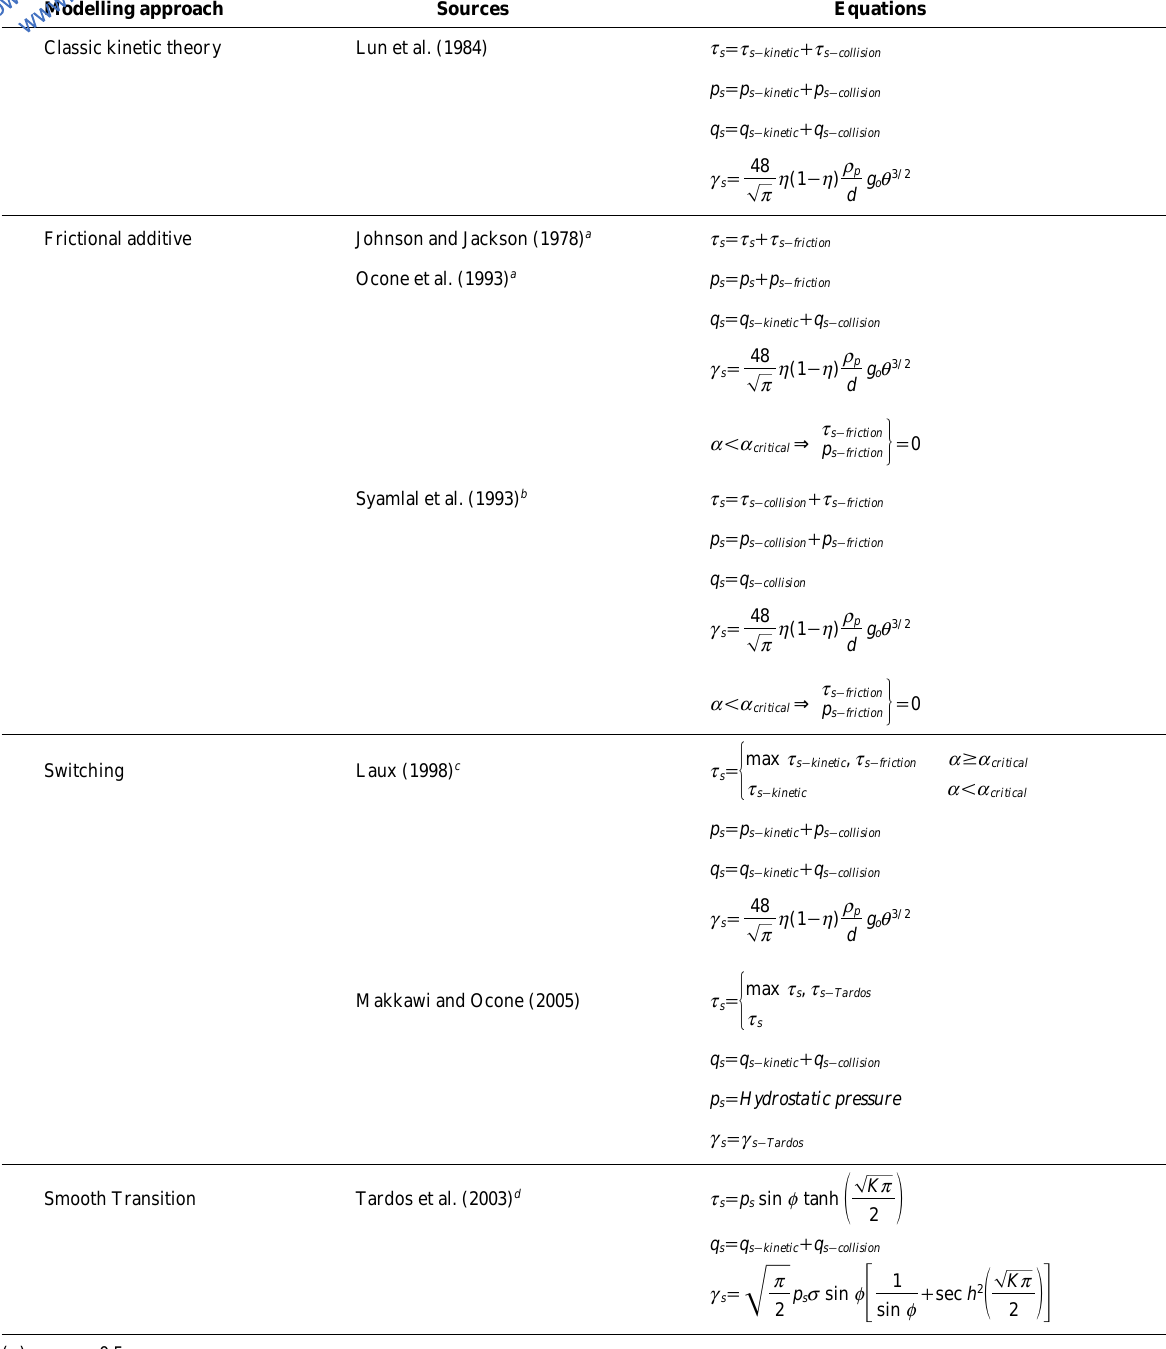
Table 1 Summary of particle stress modelling approaches and the corresponding energy balance constitutive